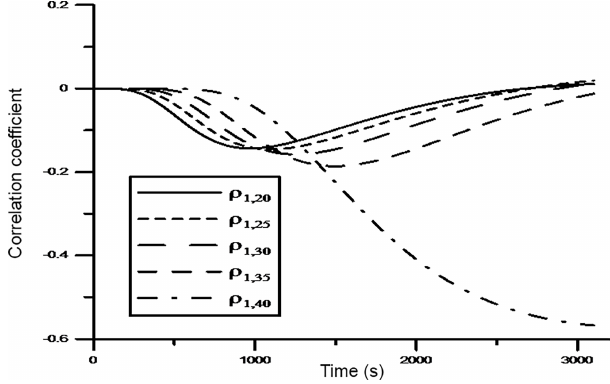
Figure 10. Time evolution of the correlation coefficients for dif- ferent bin pairs ρ 1 , 20 , ρ 1 , 25 , ρ 1 , 30 , ρ 1 , 35 and ρ 1 , 40 for a 1cm 3 sys- tem modeled with the hydrodynamic kernel, and containing initially 20 droplets of 17µm and 10 droplets of